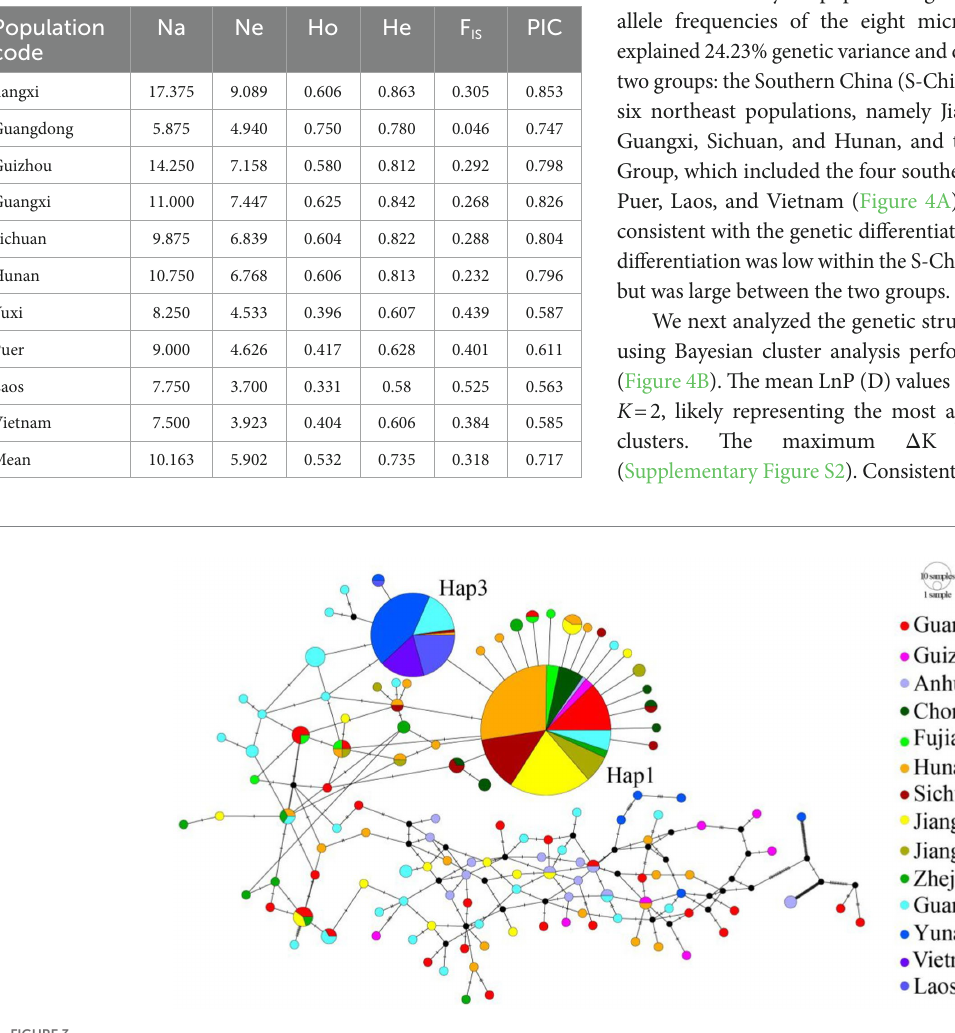
FIGURE 3 TCS haplotype networks for the mtDNA COI . Each line segment between haplotypes represents a single mutation. Black circles represent extinct or unsampled haplotypes. Size of the circles is scaled approximately to haplotype frequencies. Different colors represent different geographic populations. Population codes were given in Supplementary Tables S1, S2.